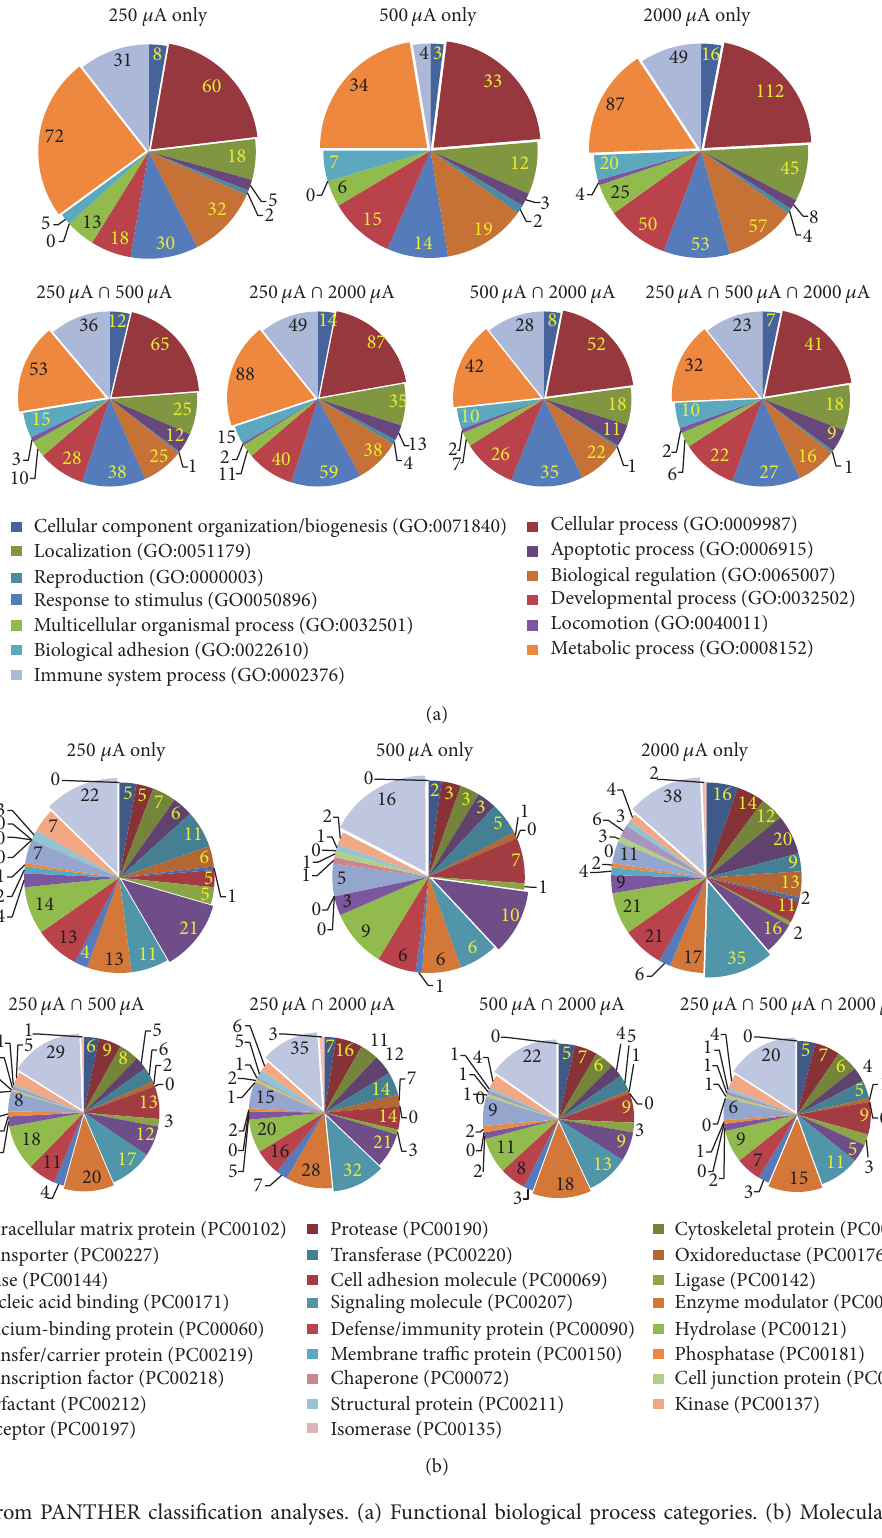
Figure 4: Results from PANTHER classification analyses. (a) Functional biological process categories. (b) Molecular functional protein